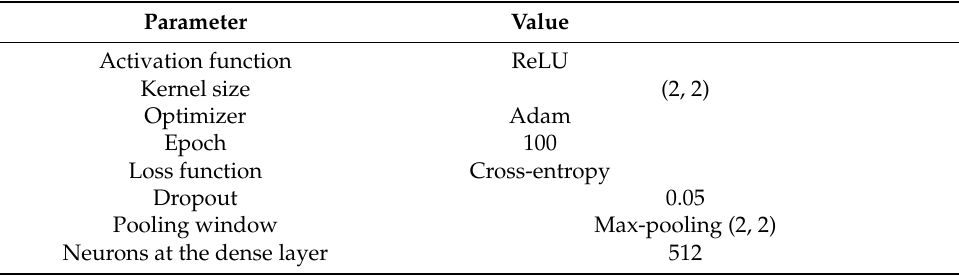
Table 3. Parameters of